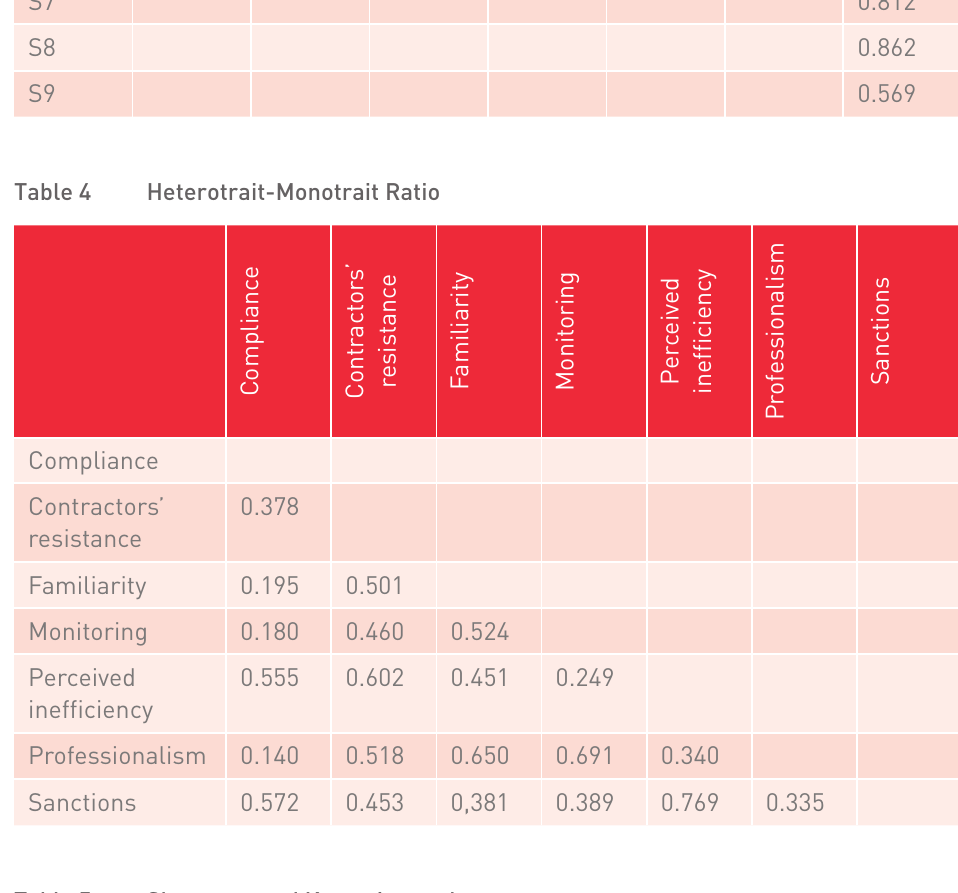
Skewness and Kurtosis